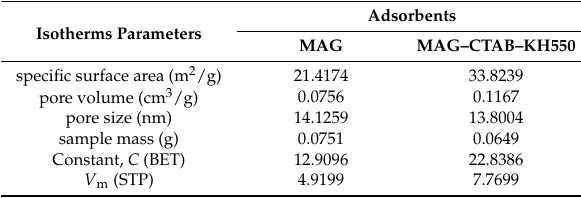
Table 1. Properties of MAG and MAG–CTAB–KH550 by N 2 adsorption/desorption isotherms analyses.